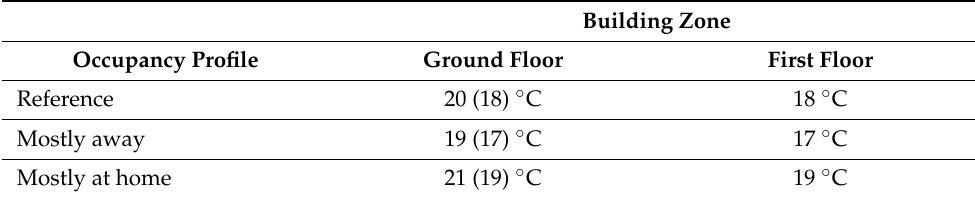
Table 5. Heating setpoint temperatures adopted in the numerical study. Between brackets the setpoint temperature adopted during the night (midnight until 7 AM).